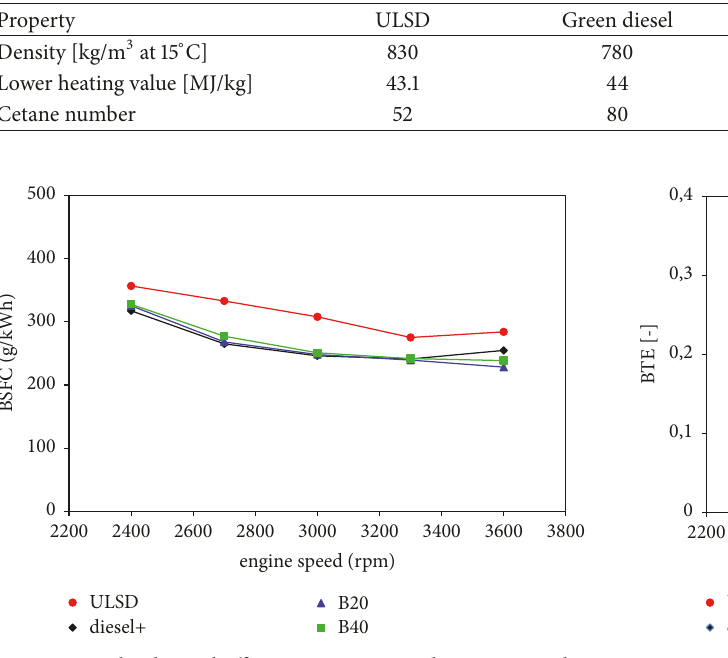
Figure 3: Brake thermal efficiency variation with engine speed at 80% load.